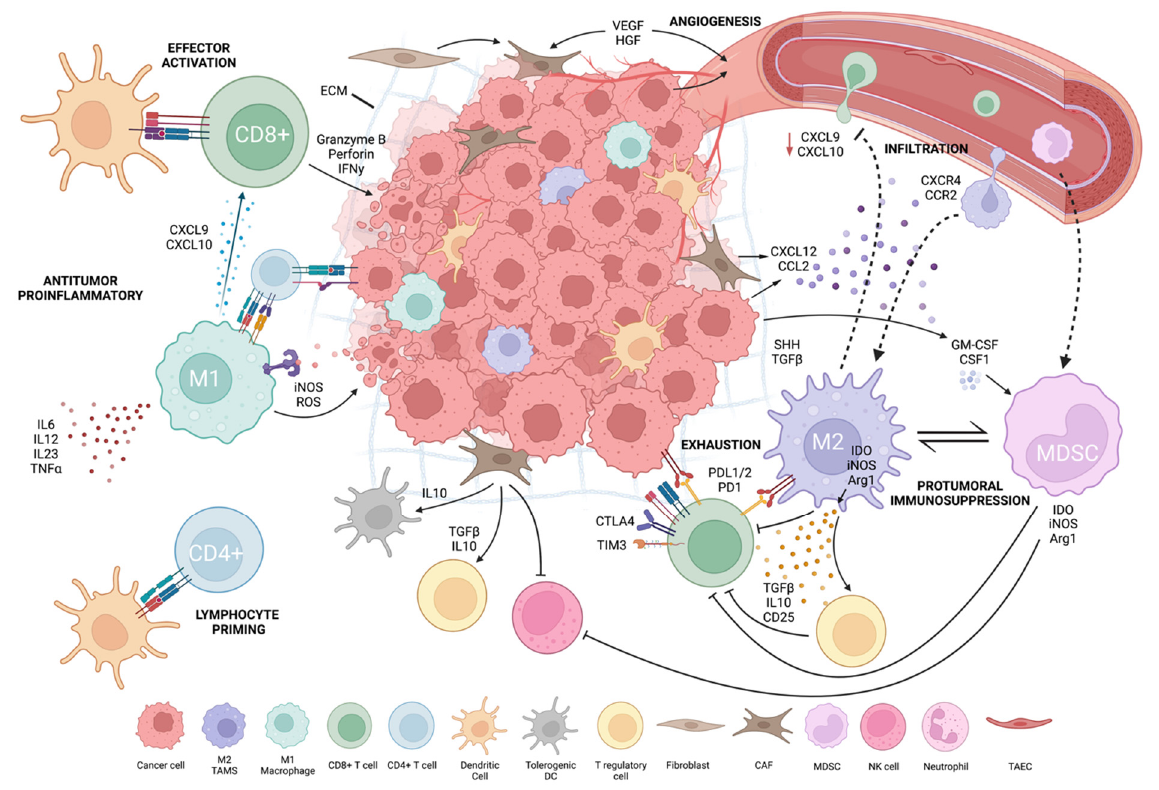
Figure 1. Tumor microenvironment.